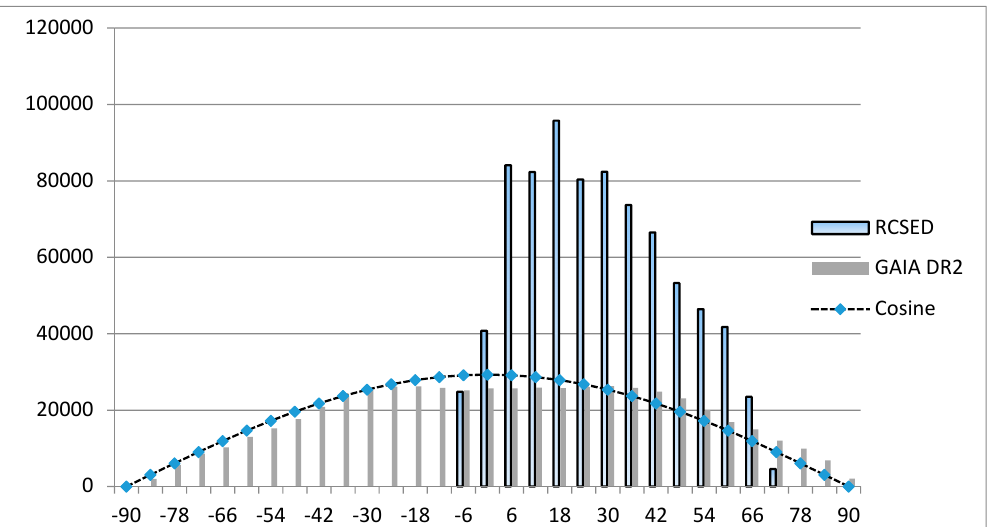
Figure 5. Histograms of dec coordinate distribution in RCSED and GAIA DR2 quasar catalogs. While Table 2. catalog shows some difference from an ideal dec angular distribution represented by the cosine function, the histogram of RCSED catalog clearly demonstrates its big angular nonuniformity.